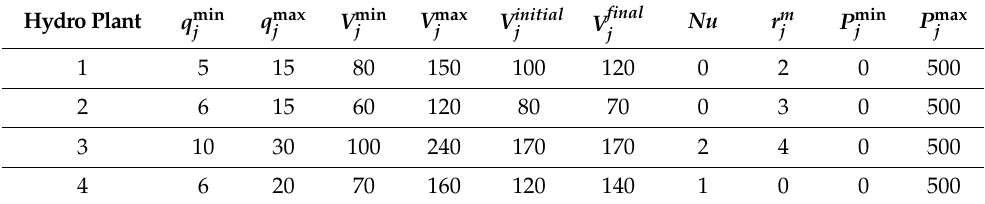
Table A1. Water discharge rate limits, reservoir storage volume limits, reservoir end storage condi-